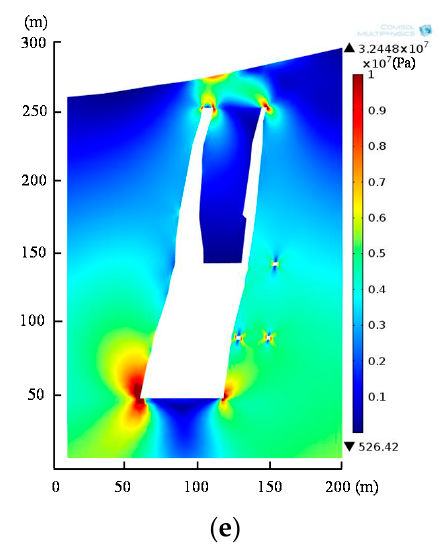
Figure 11. The surrounding rock failure mechanism in top-down mining process: ( a ) recovery of the +1035 m level, #1 and #2 represent the ore body number; ( b ) recovery of the +995 m level; ( c ) recovery of the +955 m level; ( d ) recovery of the +905 m level; ( e ) recovery of the +855 m level.